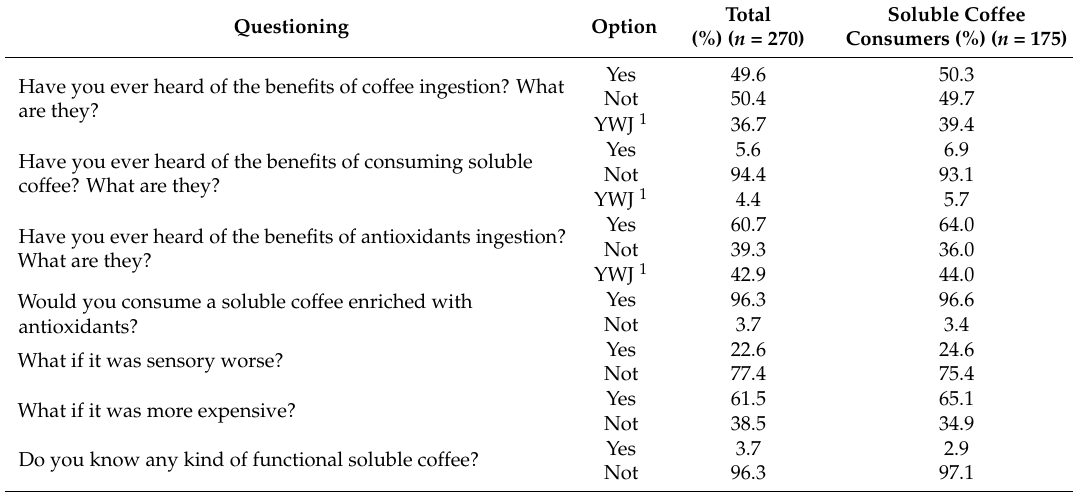
Table 5. Participants’ knowledge and attitude regarding the product studied.